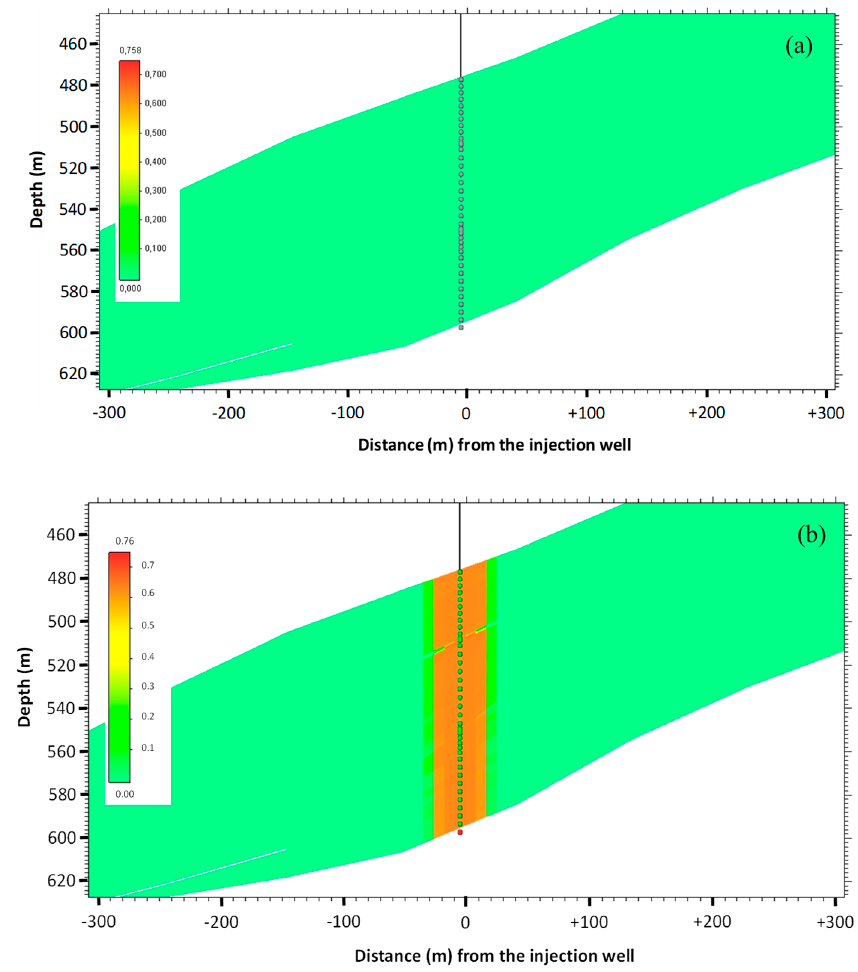
Figure 13. The simulated vertical cross-section around the injection well of the time-evolution of CO 2 saturation in the fracture during the two-phase CO 2 -brine initial ( a ) and final ( b ) injection periods. The distance to the well is a positive up dip and the depth is expressed with respect to the mean sea level.